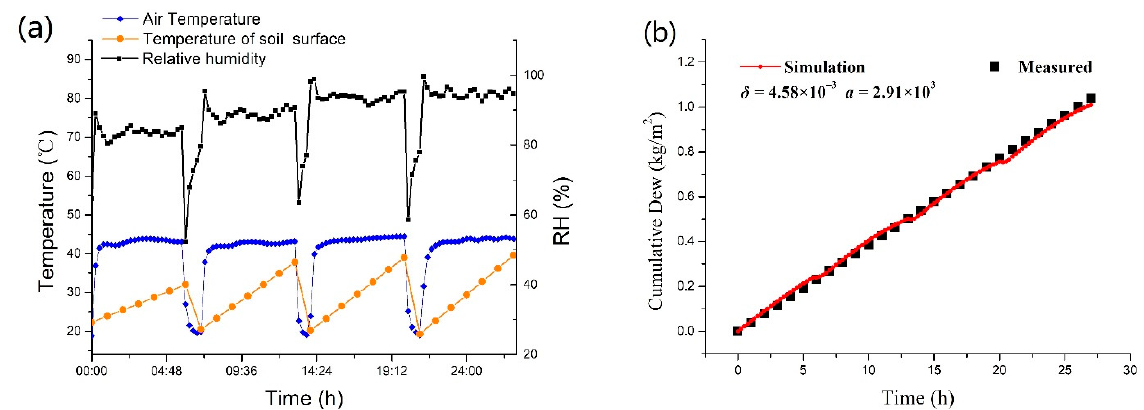
Figure 7. ( a ) Measured environmental variables [16] and ( b ) cumulative amount of dew in field experiments at the Kuahuqiao Museum. Simulation using the proposed model fitted well.